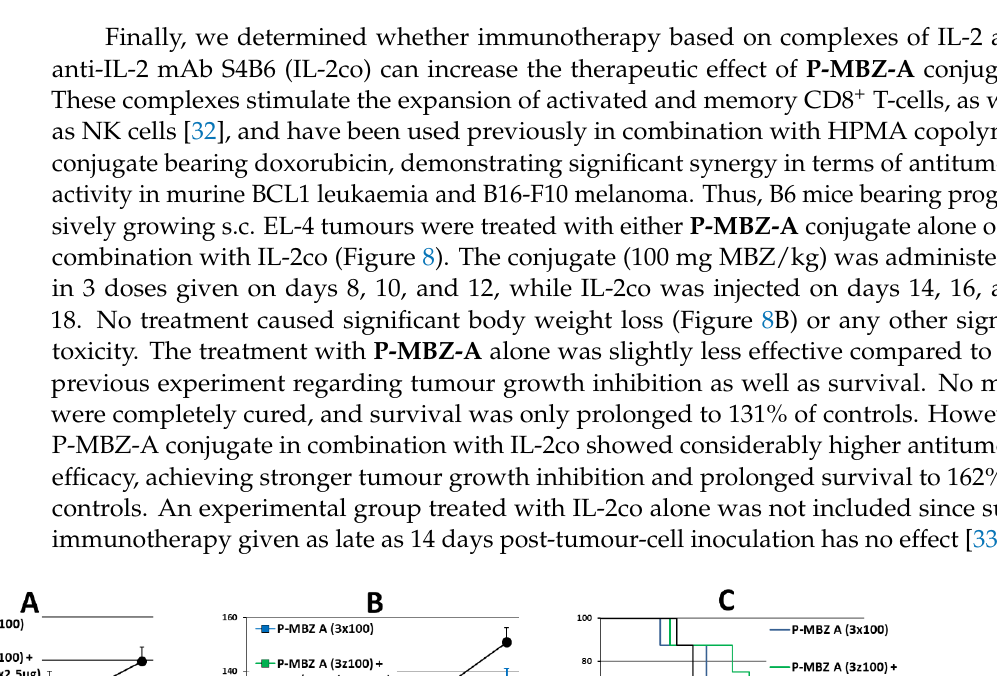
Figure 7. Antitumour activity of short-term treatment with polymer-bound mebendazole conjugate in vivo. B6 mice ( n = 7) were s.c. inoculated with 10 5 EL-4 cells on day 0, then i.p. injected, either with 1 dose (160 mg mebendazole/kg) of HPMA copolymer-bound mebendazole conjugate ( P-MBZ-A (160)) on day 8 or 3 doses (100 mg mebendazole/kg per one dose) of HPMA copolymer-bound mebendazole conjugate ( P-MBZ-A (3 × 100)) on days 8, 10, and 12. Untreated mice were used as controls. Tumour growth ( A ), body weight ( B ), and survival ( C ) were monitored, and each experimental point ( A , B ) is the average of the experimental group ± SD.